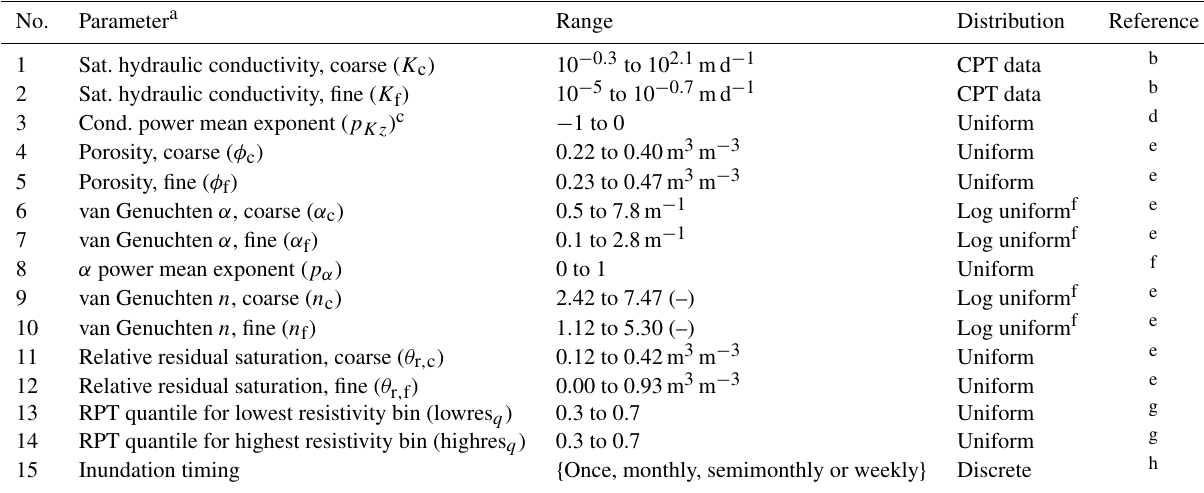
Table 1. Parameter ranges sampled during Monte Carlo